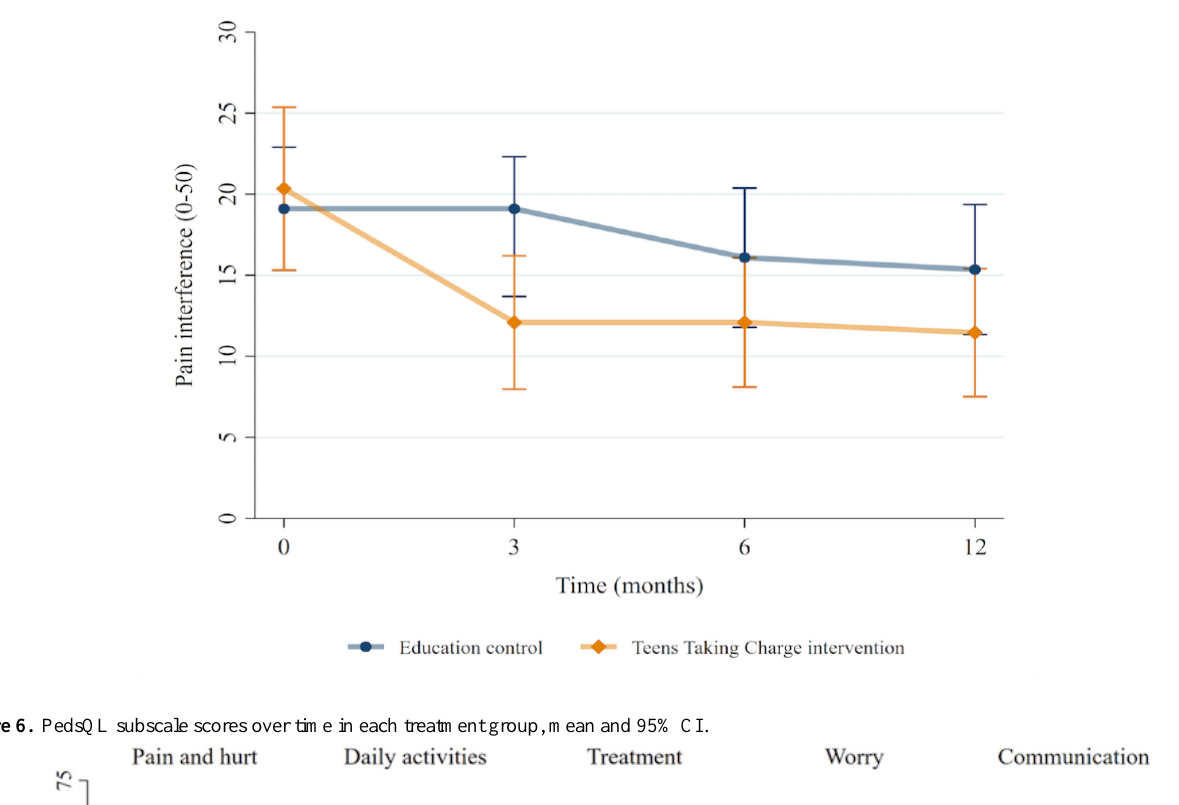
Figure 5. Pain interference scores over time in each treatment group, mean and 95% CI.